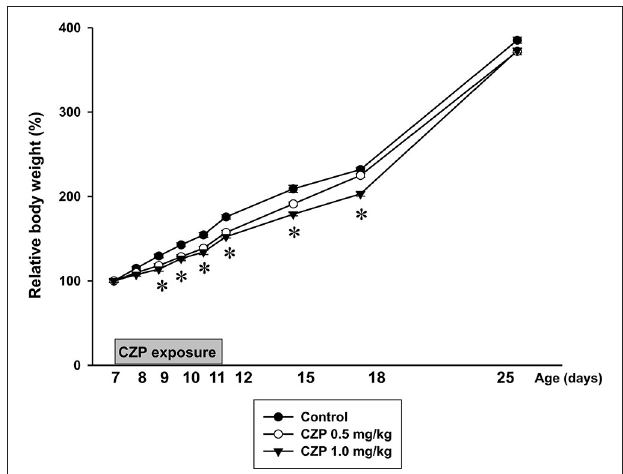
FIGURE 3 | Body weight (mean +SEM) of rats during CZP exposure and at P12, P15, P18 and P25 . Abscissa: age in days, ordinate: relative weight (body weight on the first day of the drug administration was taken as 100%). * Significant difference compared to appropriate control groups.